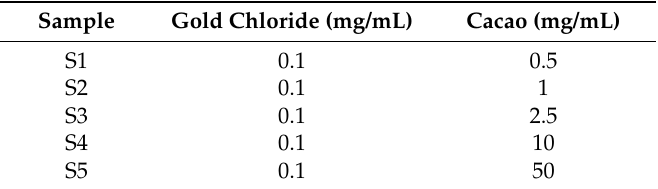
Table 1. Concentrations of reactants used for the synthesis of different cacao-gold nanoparticles